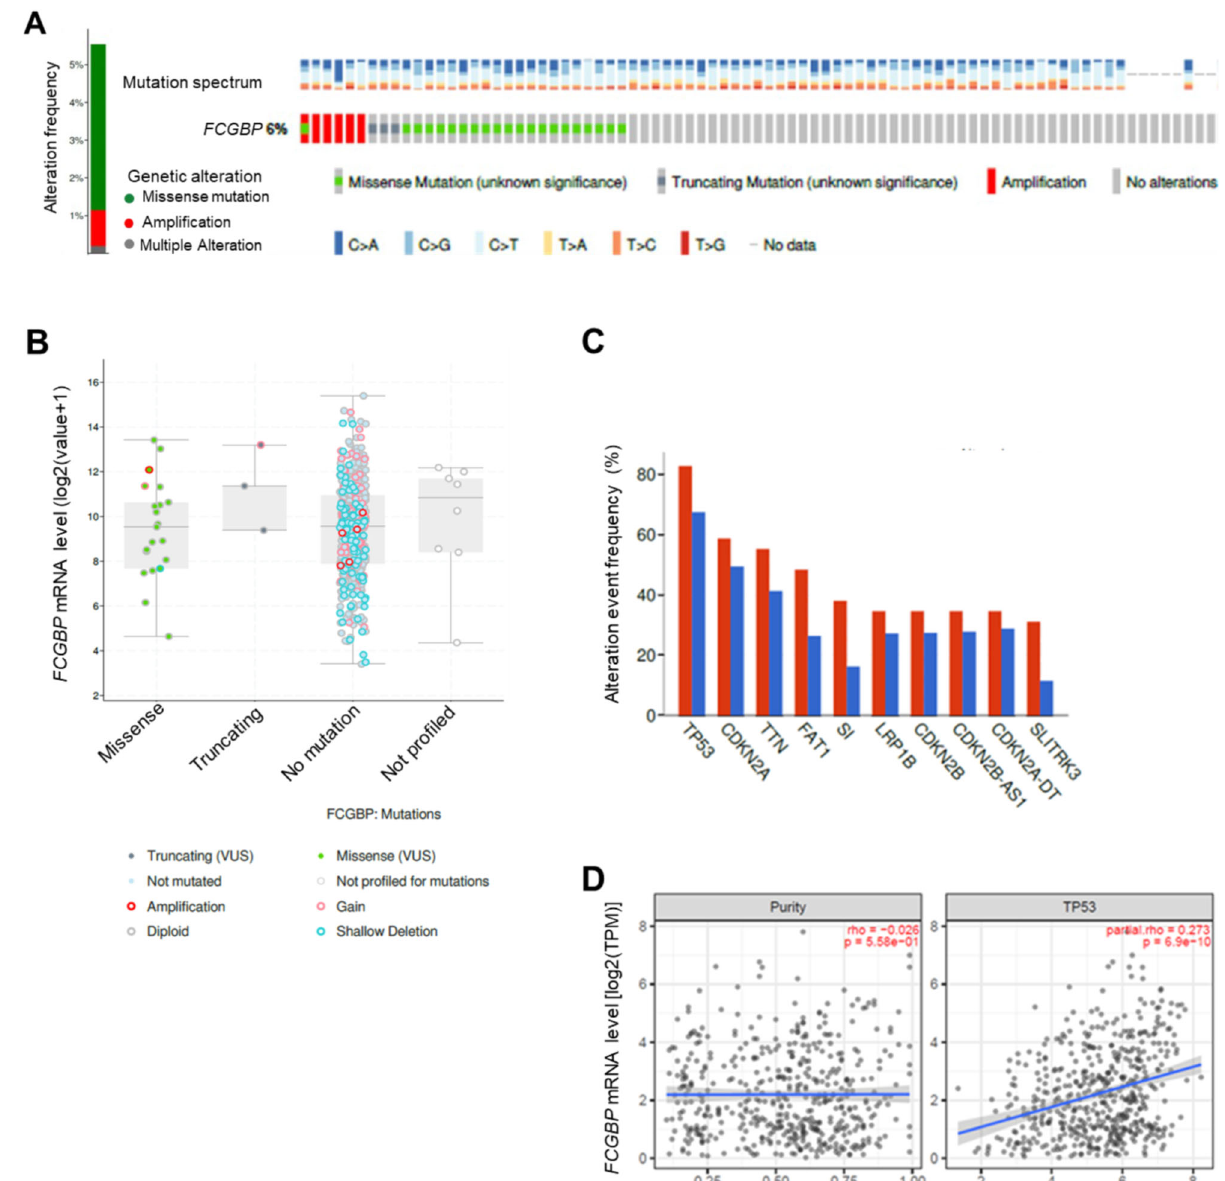
Figure 3. Genetic alterations and correlation analysis on the FCGBP in HNSC patients. ( A ) cBioPortal showed the FCGBP genetic alterations and mutation frequencies. Different colors indicate dissimilar types of genetic alterations. ( B ) The relationships between the FCGBP variants and their correspond ‐ ing mRNA levels (RNA ‐ Seq by Expectation ‐ Maximization: RSEM), batch normalized from Illumina Hiseq_RANSeqV2. ( C ) The most frequently altered genes with FCGBP alteration in HNSC ( n = 523). ( D ) TIMER2.0 analyzed the correlations between FCGBP mRNA level and tumor purity ( left ) and TP53 mRNA level ( right ).